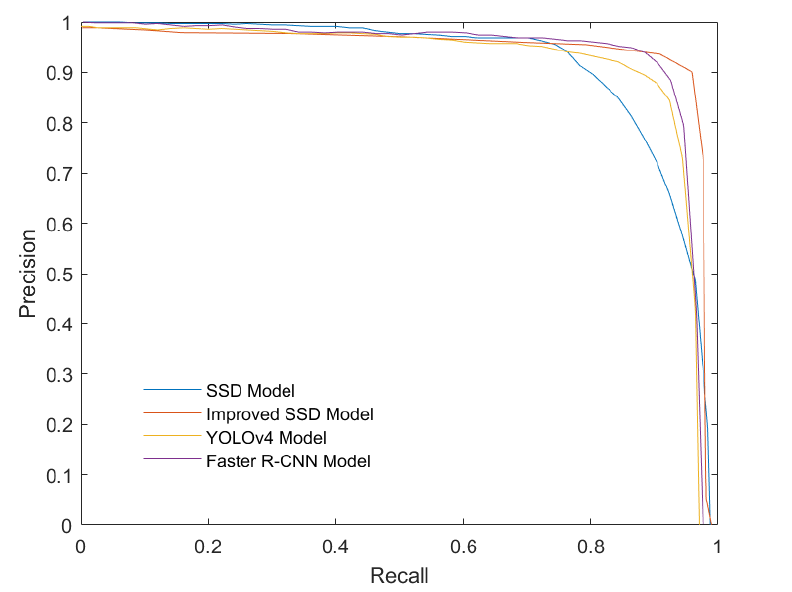
Figure 13. Four models comparison of P-R